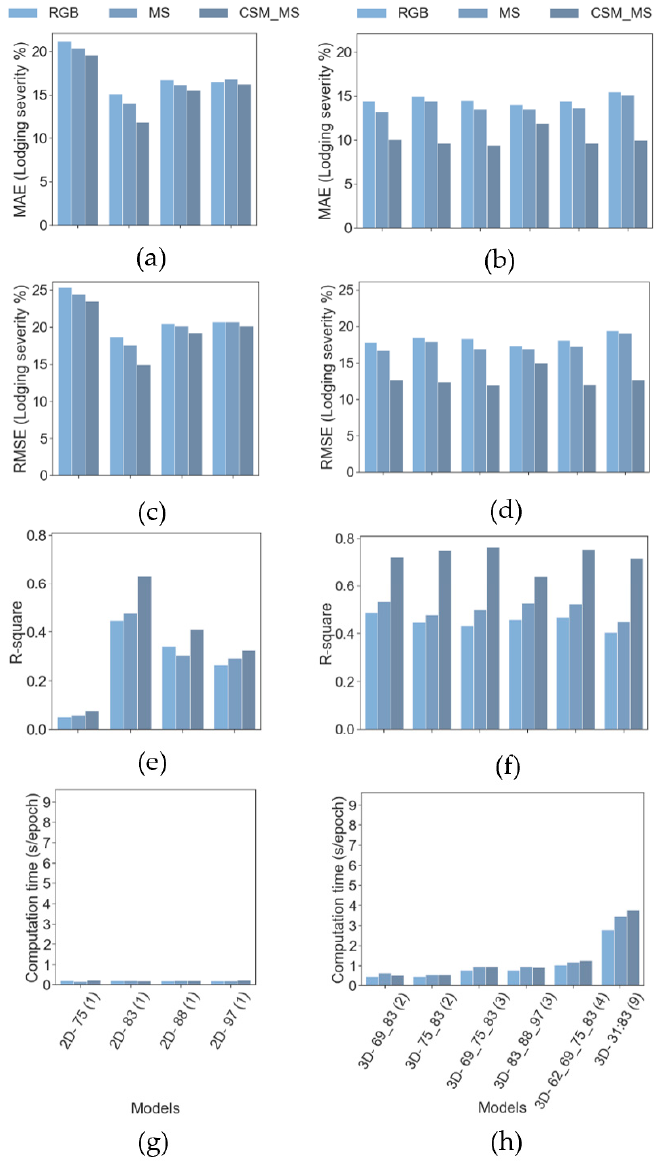
Figure 5. Evaluation of lodging severity prediction in testing data for 2D models by DAP and 3D models by number of time frame sequences via MAE ( a , b ), RMSE ( c , d ) and R 2 ( e , f ) metrics. Computation time for 2D models ( g ) and 3D models ( h ) with a batch size of 32 samples during model training step.